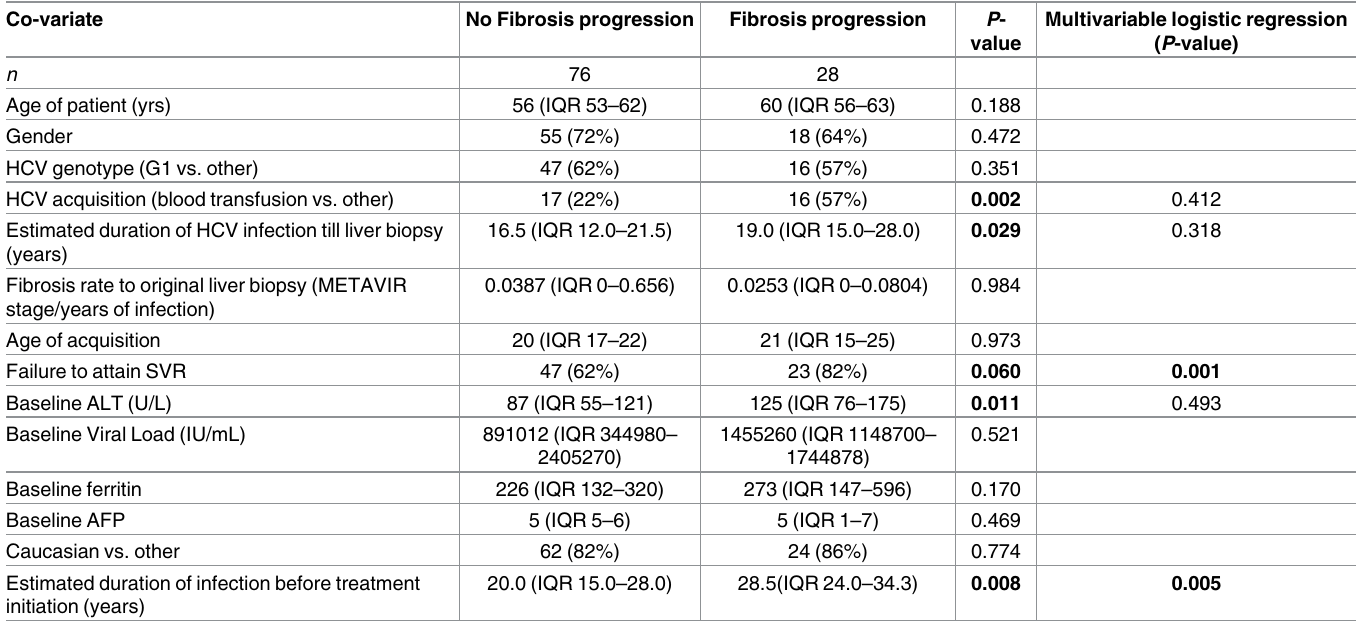
Table 3. Predictors of liver fibrosis progression—Failure to attain SVR and longer duration of infection prior to HCV treatment. Co-variate